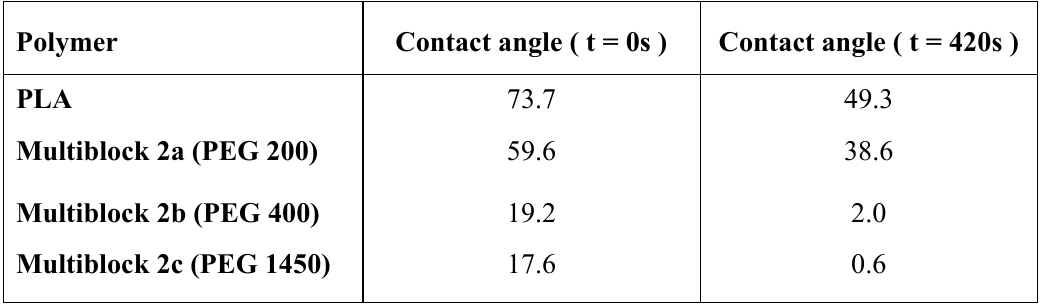
Table 3: Contact angle for multiblock copolymers